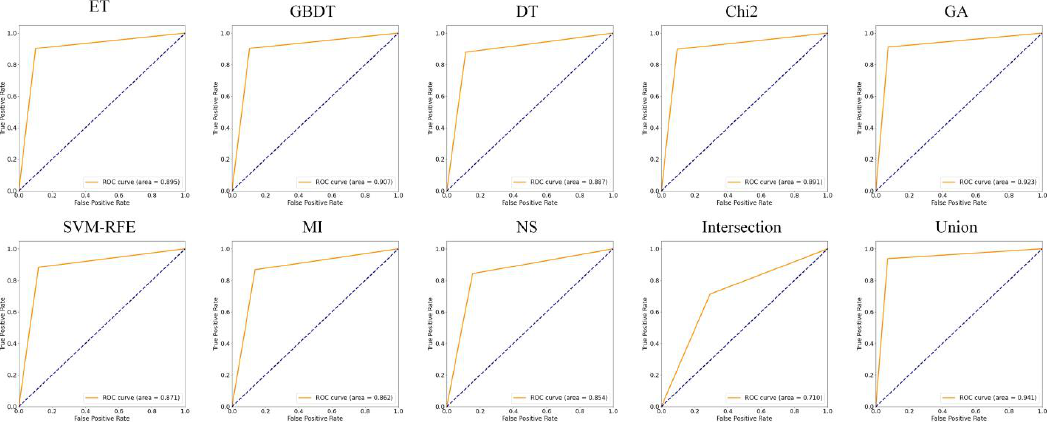
Figure 8. ROC curves of different feature selection methods on OmniDroid dataset.